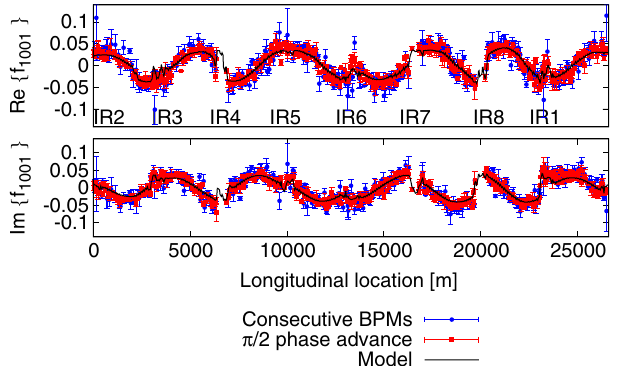
FIG. 2. Comparison of reconstructing the coupling using consecutive BPMs (blue) and BPMs with close to π advance (red) for simulated data.